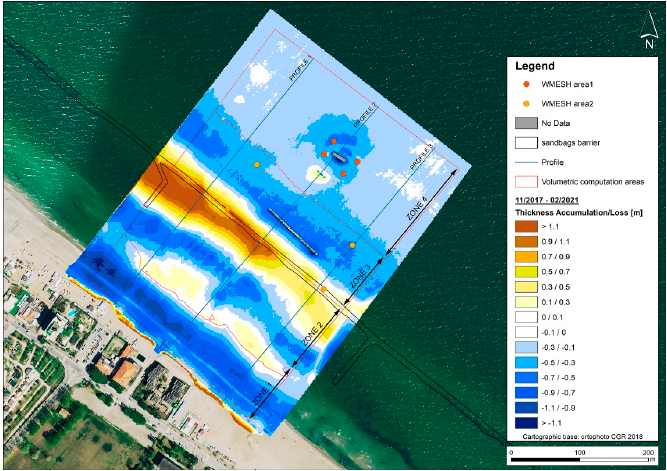
Figure 9. Difference maps between November 2017 and February 2021 DTMs. The traces of the bathymetric profiles of Figure 10 and the subdivision in subzones selected for partial volumetric estimations are